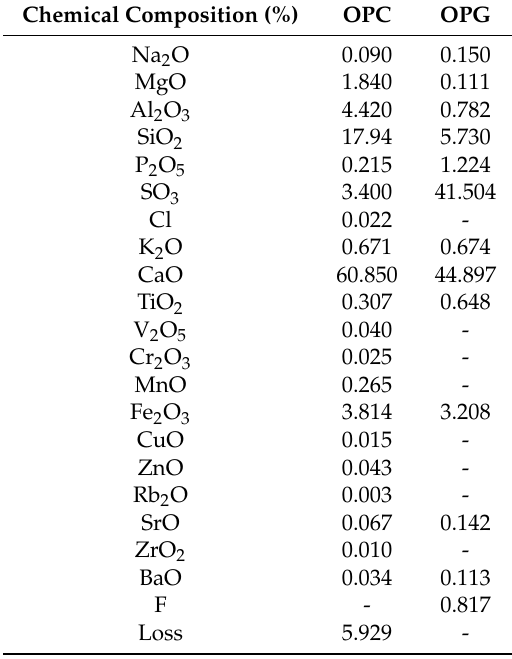
Table 1. Chemical compositions of ordinary Portland cement (OPC) and ordinary phosphogypsum (OPG).